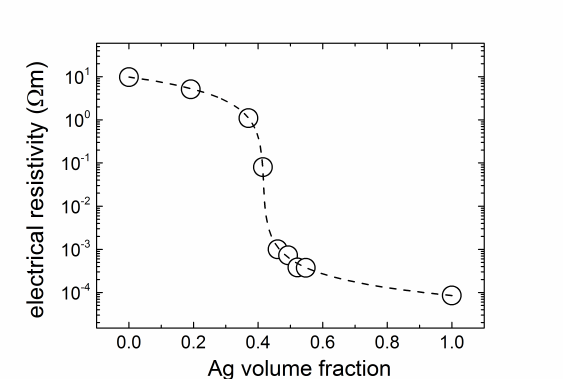
Figure 6. Electrical resistivity of composite Ag-LaCoO 3 pellets sintered at 1000 ◦ C for 1 h. The dashed line is fit to data by using Equation (1). The obtained value of A (cid:39) 1.5 corresponds to slightly deformed